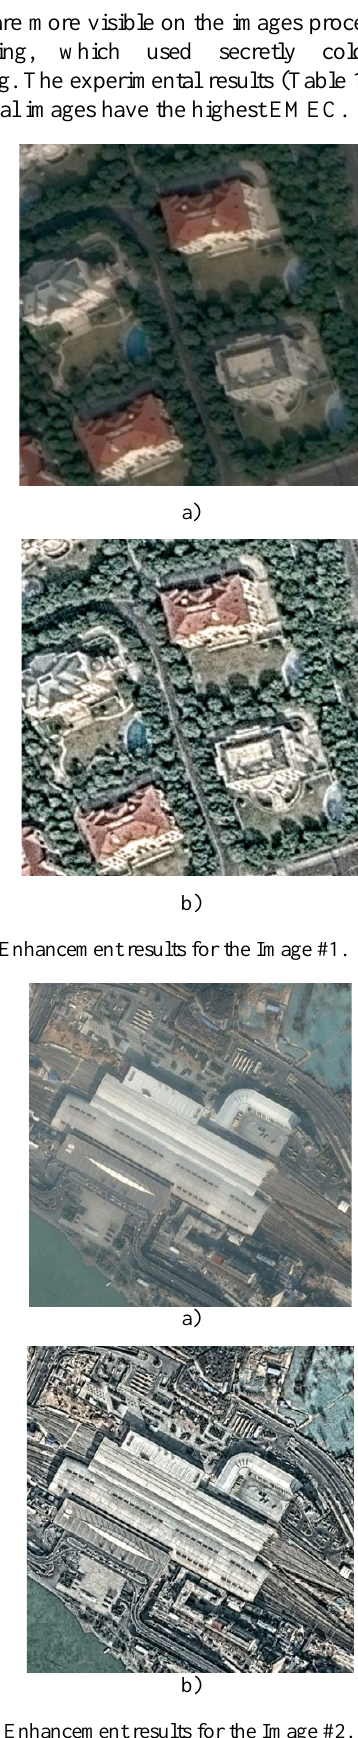
Fig. 5 . Enhancement results for the Image